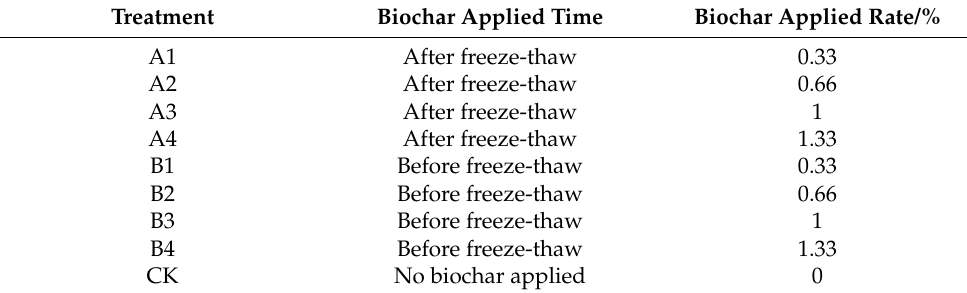
Table 3. Biochar applied timing and rate in each